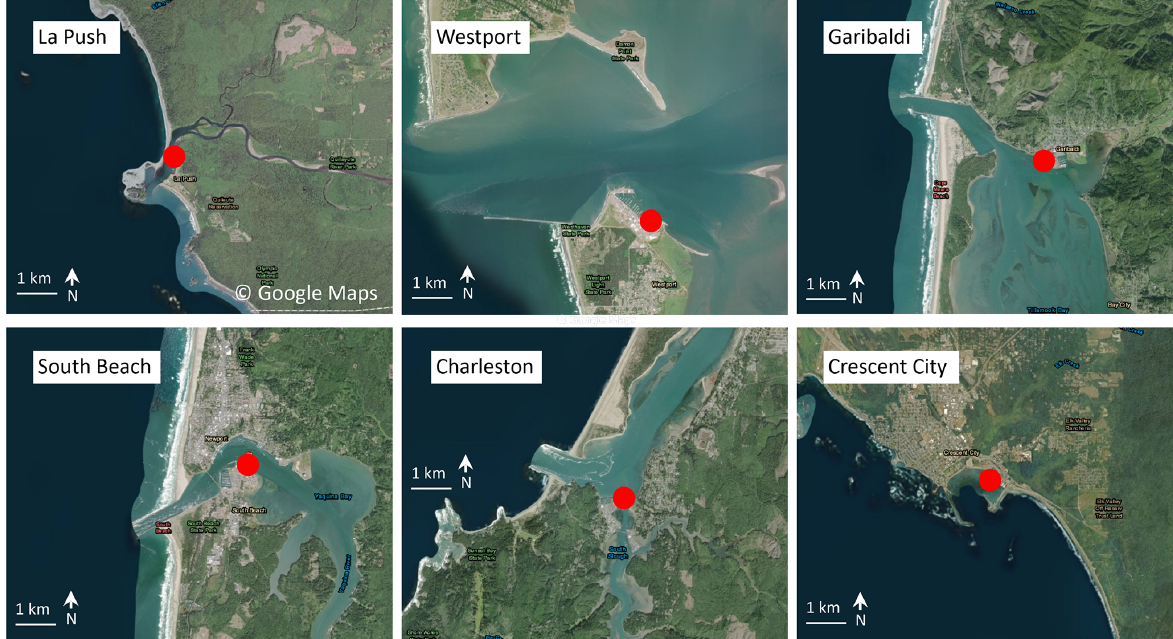
Figure 4. Locations of NOAA tide gages (red dots) (from NOAA, 2020b). Satellite images are from © Google